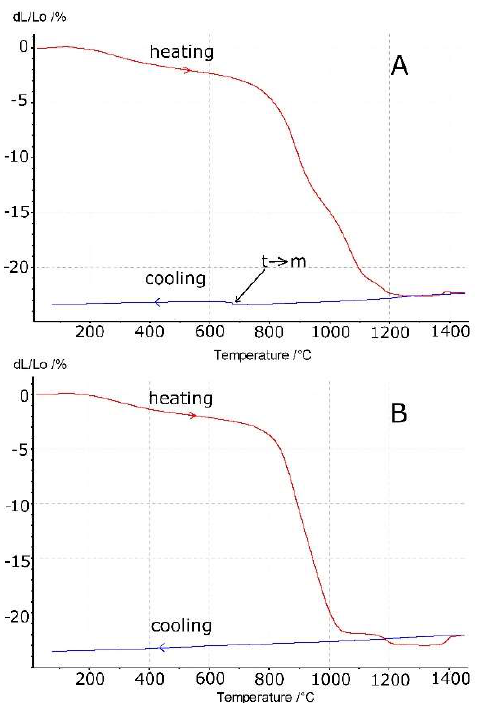
Figure 4. Dilatometric curves. Rate of temperature increase and decrease of 5 °C/min. The plots also show the behavior of the samples during cooling with a rate of temperature decrease of 5 °C/min. ( A ) 7.4 mol% MgO–ZrO 2 ; ( B ) 11.5 mol% MgO–ZrO 2 .